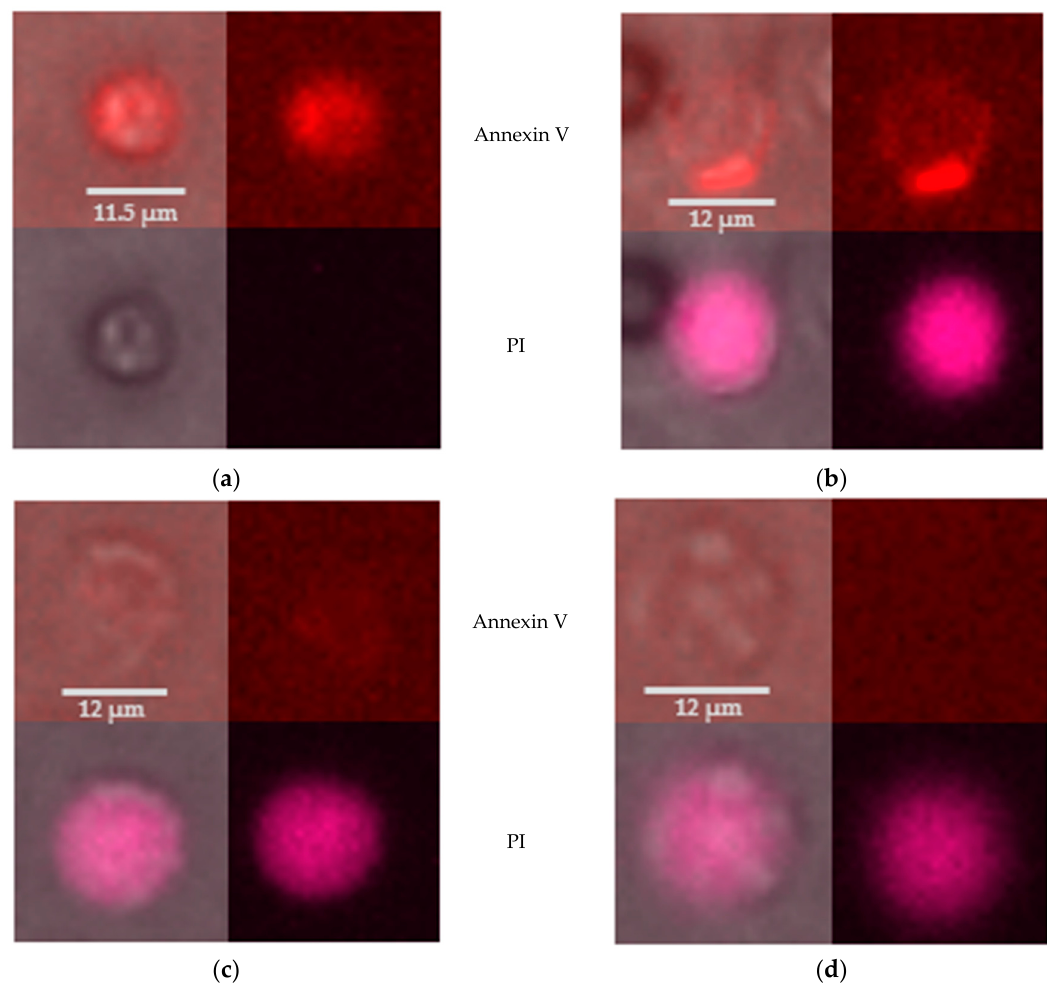
Figure 3. PMNs 72 h post withdrawal at different stages of the apoptotic process; left images: phase contrast + fluorescence channel; right images: fluorescence channel only; annexin V-FITC staining (top row), PI staining (bottom row). ( a ) Early apoptotic PMN: annexin V + but PI − ( b ) Apoptotic PMN: annexin V + and PI + ( c ) Late apoptotic PMN: weakly annexin V + and PI + ( d ) Late apoptotic/necrotic PMN: annexin V − but PI + .